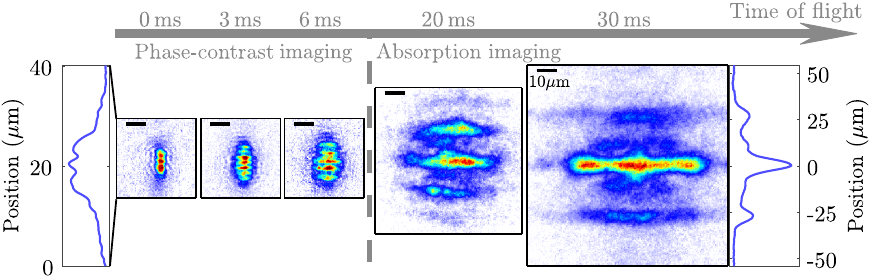
FIG. 3. Evolution from in situ density distribution to time-of-flight interference. On the left-hand side, we show an exemplary in situ image together with the integrated density distribution for the phase-coherent droplet regime, revealing a clear density modulation. Towards the right-hand side, we show the expansion dynamics for different times of flight, which exhibits the characteristic increase of the fringe spacing of expanding matter waves. On the very right, we show the interference pattern after 30 ms time of flight together with the corresponding integrated momentum distribution. In these interference patterns a clear substructure at half the principle fringe spacing can be seen. While the principle interference peaks yield information about the nearest-neighbor coherence, the additional peaks correspond to next-nearest-neighbor coherence. The individual images shown result from independent experimental